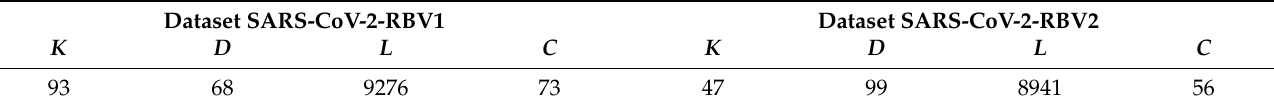
Table 4. Optimal reservoir parameters.